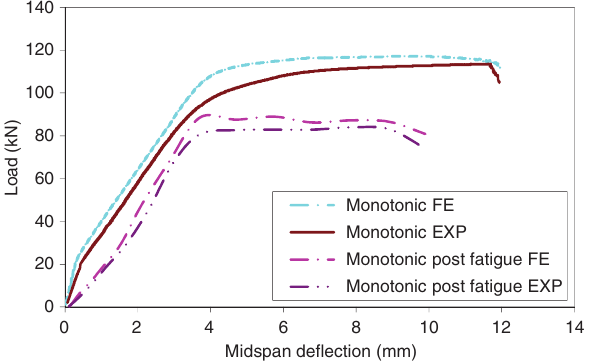
Figure 13: Variation in the longitudinal strain of CFRP at mid-span versus load cycle.